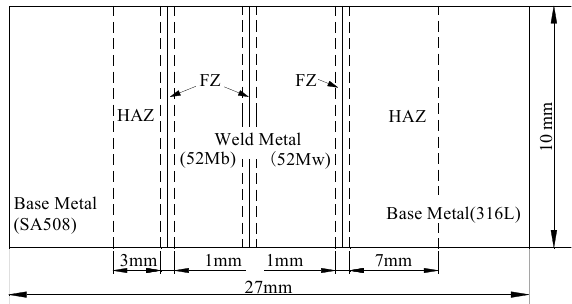
Figure 4. Schematic diagram of each region in the simplified welded structure.